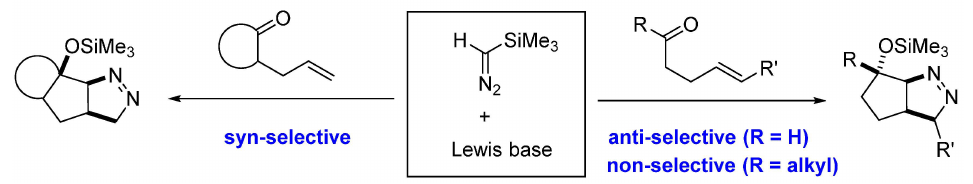
Figure 2. Selectivity in formation of ∆ 1